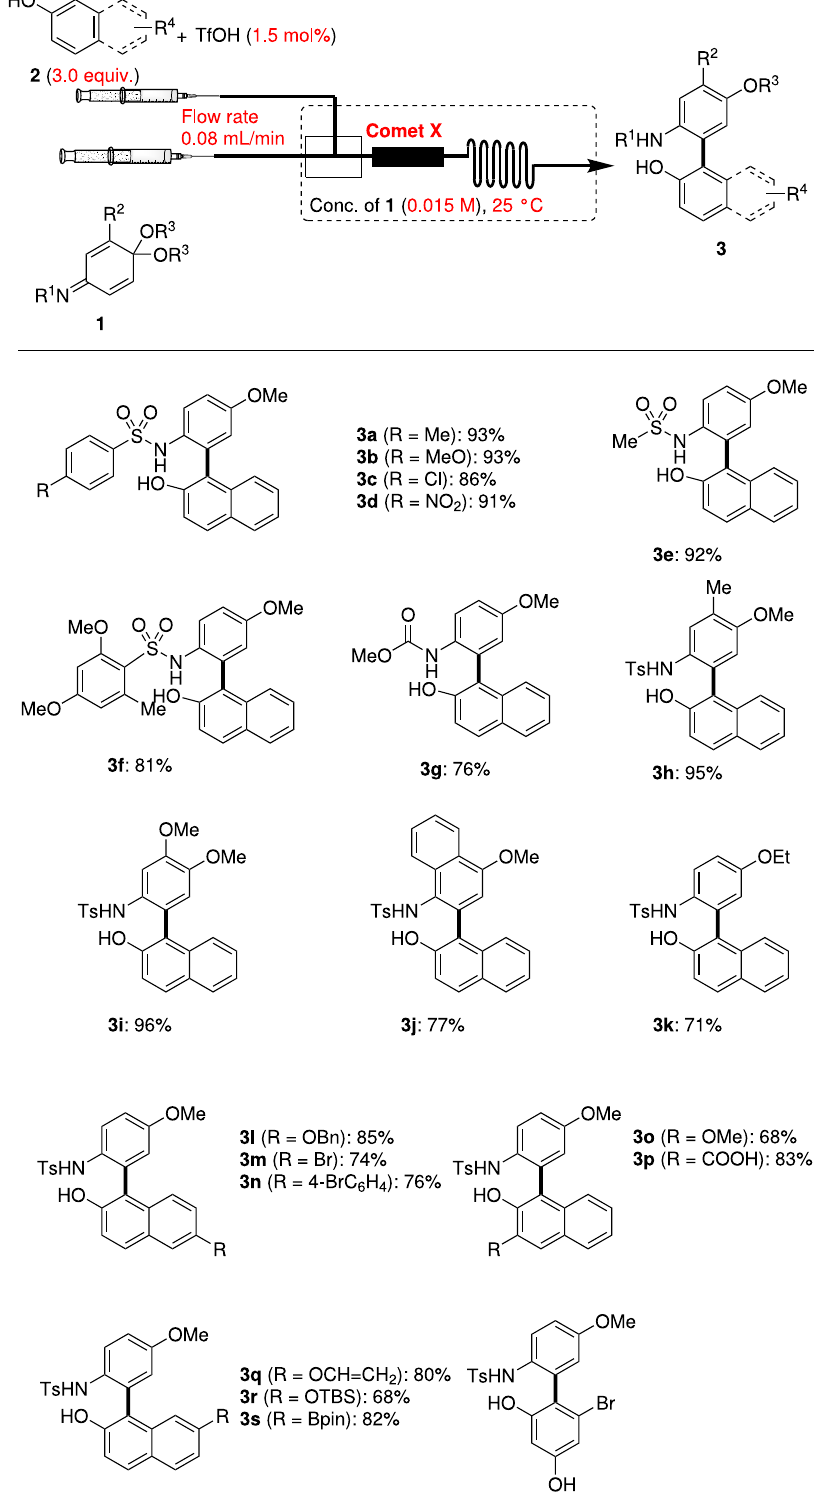
Fig. 2 Substrate scope of cross-coupling using IQMAs 1 and arenols 2 a . Yields are those of isolated 3 . a Reaction conditions: 1 (0.065 mmol), 2 (3.0 equiv.), and TfOH (1.5 mol%) in degassed dry toluene (0.015 M), micro mixer: Comet X, fl ow rate: 0.08 mL/min, at 25